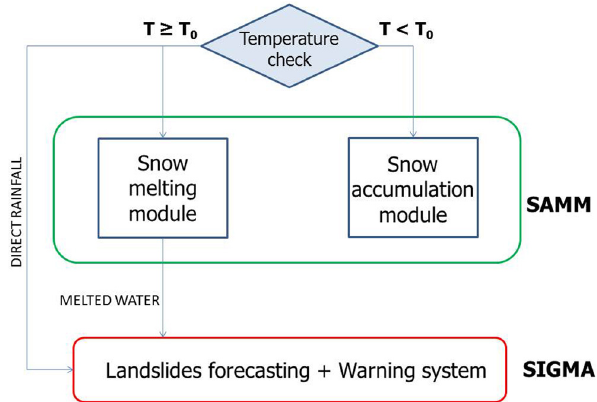
Fig. 10. Integrated system SAMM–SIGMA for landslides forecast- ing. Table 5. Results of the simulation of an integrated use of SAMM and SIGMA (period 2004–2010). Landslides Landslides identified